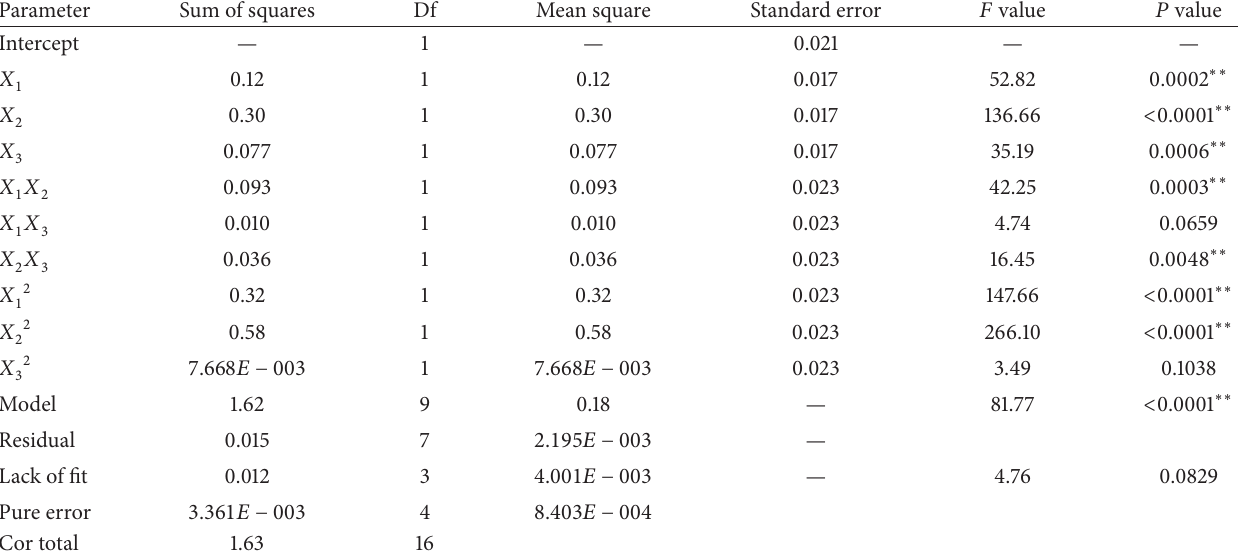
Table 3: Analysis of variance of regression